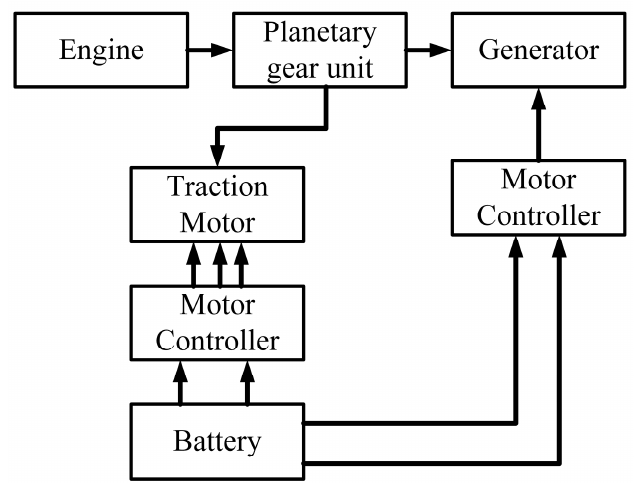
Figure 21. Drive train of series-parallel hybrid system using planetary gear unit. The planetary gear unit combines the engine, the generator and the motor [30]. Energies 2017 , 10 , 1217